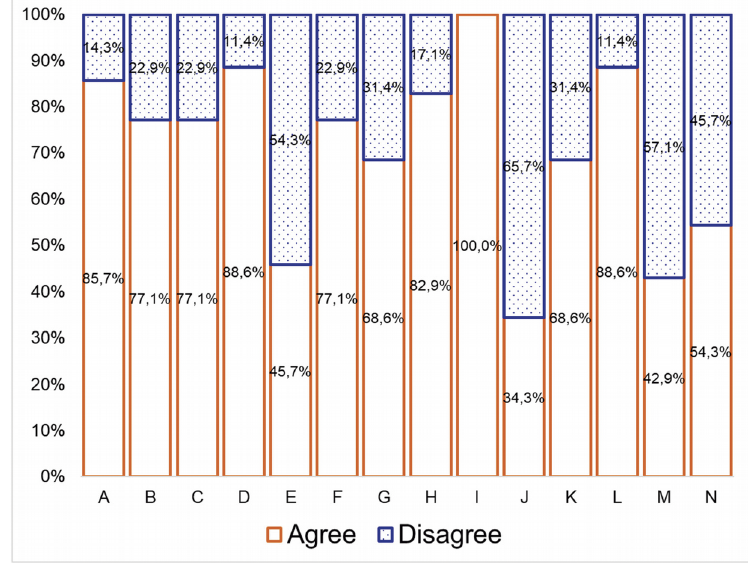
Figure 4. Survey 1 results: the perception of the use of virtual systems, device availability and internet